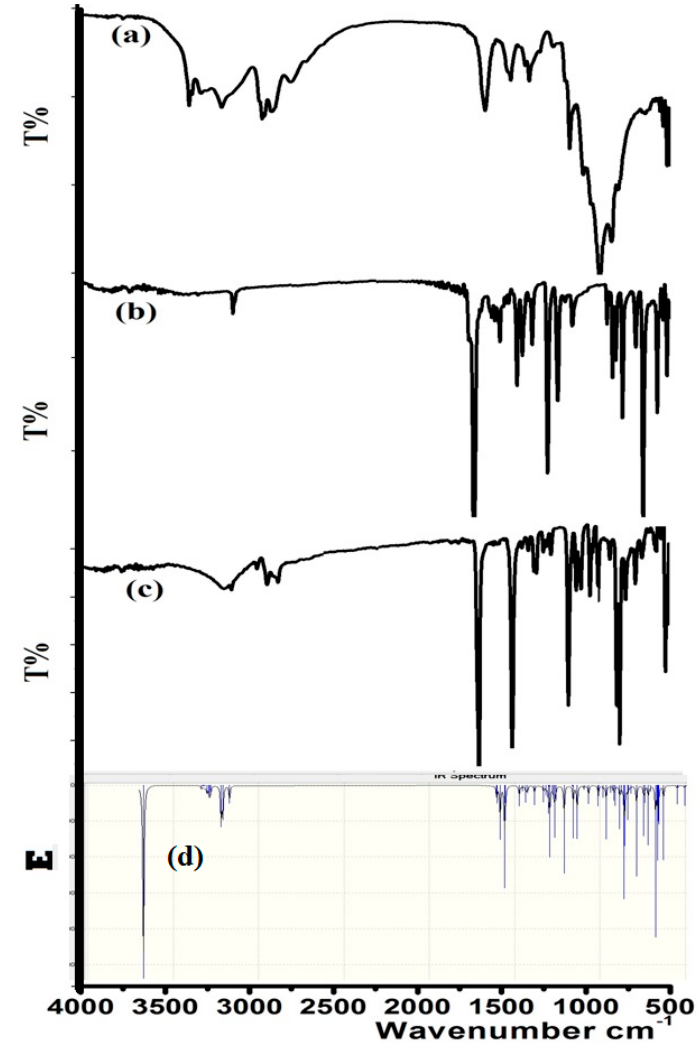
Figure 2. IR spectra of (a) 1,3-diaminopropan-2-ol, (b) 3-bromobenzaldehyde, (c) 1,3-bis[( E